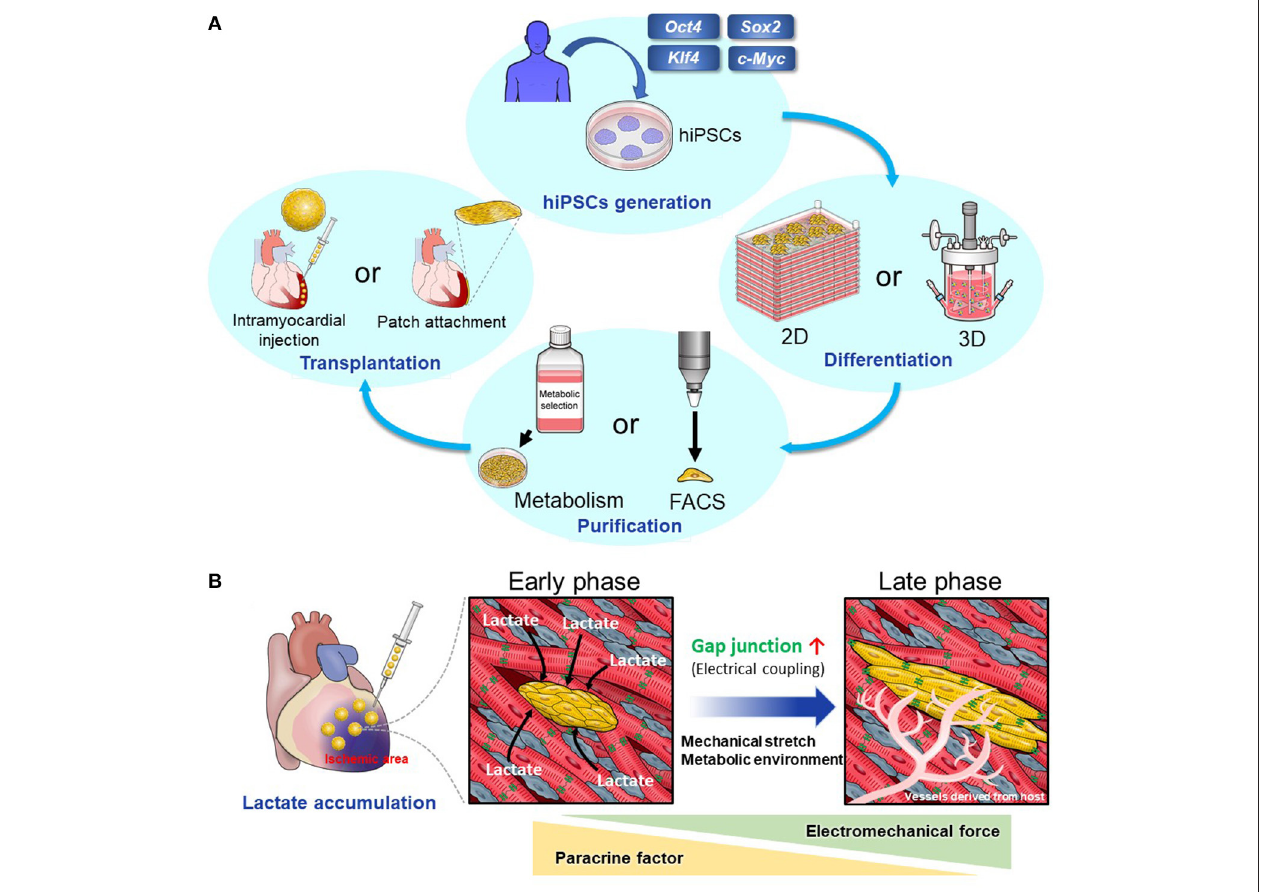
FIGURE 1 | (A) The scheme of cardiac regenerative therapy. hPSCs were established by introducing transcription factors including Oct4, Sox2, Klf4, and c-Myc to human somatic cells. Two-dimensional or three-dimensional large-scale culture systems for hPSCs and hPSC-CMs have been developed. Using these systems, we can culture a large number of hPSCs and induce their differentiation into CMs effectively. Elimination of non-CMs including undifferentiated hPSCs is important to prevent tumorigenesis. Particularly, metabolic selection is useful and cost-effective. Then, we transplant hPSC-CMs into the host myocardium. There are two main methods. One method is to transplant hPSC-CMs as a patch onto the host epicardium. The other method is to inject them using a needle into the host myocardium. (B) Intramyocardial transplantation of metabolically selected cardiomyocytes. hPSC-CMs that have undergone the metabolic selection in glucose- and glutamine-free medium supplemented with lactate are likely to engraft and become mature when they are transplanted into the ischemic region because of lactate accumulation. There is a high density of host-derived microvessels within the graft, which promotes the engraftment and maturation of transplanted